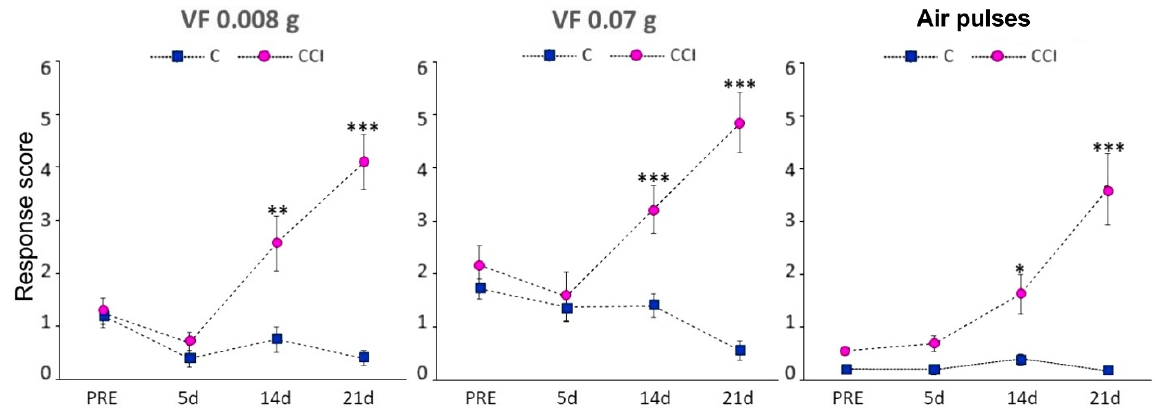
Figure 1. Behavioral responses following CCI-IoN to stimulation of the whisker pad with 0.008 g or 0.07 g Von Frey filaments, or 10 psi air-puff pulses. The response score before surgery (PRE) represents the average of three consecutive testing days. At 14 and 21 postoperative days the response score differed significantly between operated ( n = 6, right side, magenta circles) and control ( n = 5, blue squares) cases. The latter included responses from both sides, because there were no left-right differences in these cases. Data represent means ± SEM. Significance is represented by *, ** and ***, corresponding to p < 0.05, p < 0.01 and p < 0.001, respectively (two-tailed Mann-Whitney test).